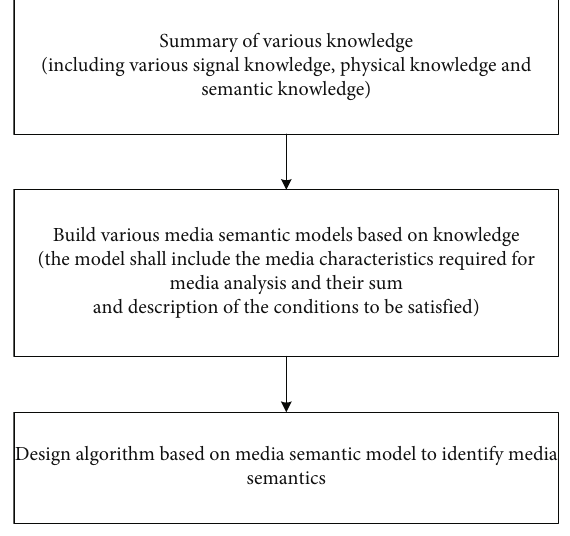
Figure 1: Steps of multimedia fusion analysis.